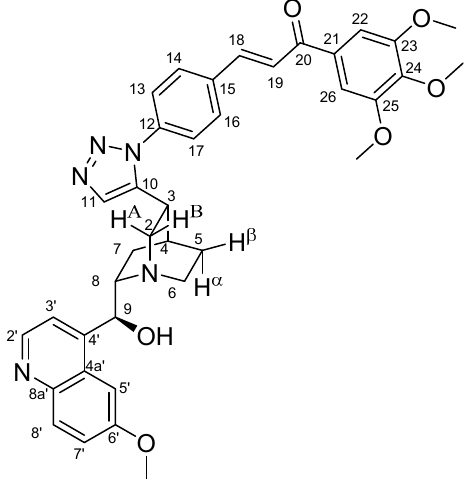
Molecules 2019 , 24 , x FOR PEER REVIEW 24 of 30 Yellow solid; Yield: 148 mg (24%); MP.: ~188 °C (dec., from diethyl ether); 1 H-NMR (DMSO- d 6 at 45 °C): 9.06 (br s, 3H, C24OH), 8.78 (s, 1H, H11), 8.64 (d, J = 4.5 Hz, 1H, H2 ′ ), 8.05 (d, J = 8.7 Hz, 2H, H14 and H16), 7.98 (d, J = 8.7 Hz, 2H, H13 and H17), 7.90 (d, J = 15.6 Hz, 1H, H19, overlapped by H8 ′ ), 7.90 (d, J = 9.2 Hz, 1H, H8 ′ , overlapped by H19), 7.77 (s, 2H, H22 and H26), 7.68 (d, J = 15.6 Hz, 1H, H18, overlapped by H5 ′ ), 7.66 (1H, H5 ′ , overlapped by H18), 7.49 (d, J = 4.5 Hz, 1H, H3 ′ ), 7.35 (dd, J = 9.2 Hz, 2.7 Hz, 1H, H7 ′ ), 6.11 (br s, 1H, H9), 6.05 (br s, 1H, C9OH), 4.14 (br m, 1H, H2A), 3.97 (s, 3H, C6 ′ OCH 3 ), 3.48 (br m, 1H, H2B), 3.40 (br m, 1H, H8), 3.35 (br m, 1H, H3), 3.18 (br m, 1H, H6 α ), 3.08 (br m, 1H, H6 β ), 2.29 (br m, 1H, H4), 2.24 (s, 6H, CH 3 ), 2.19 (br m, 1H, H7 β ), 1.78–1.85 (br m, 2H, H5 α and H5 β ), 1.34 (br m, 1H, H7 α ); 13 C-NMR (DMSO- d 6 at 45 °C): 188.0 (C20), 158.8 (C6 ′ ), 158.1